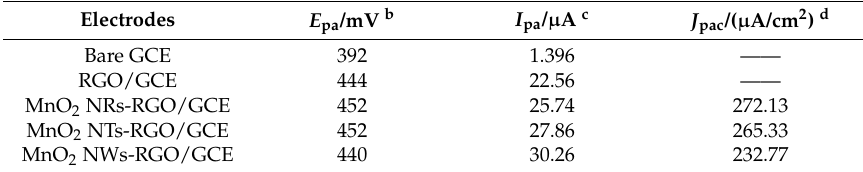
Table 1. The second-order derivative linear sweep voltammetric (SDLSV) response of dopamine on the different electrodes a